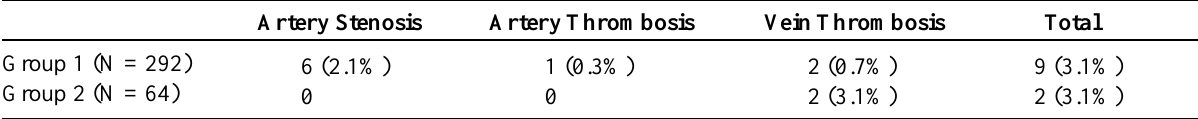
Table 4 – Vascular complications among single (group 1) and multiple (group 2) arteries